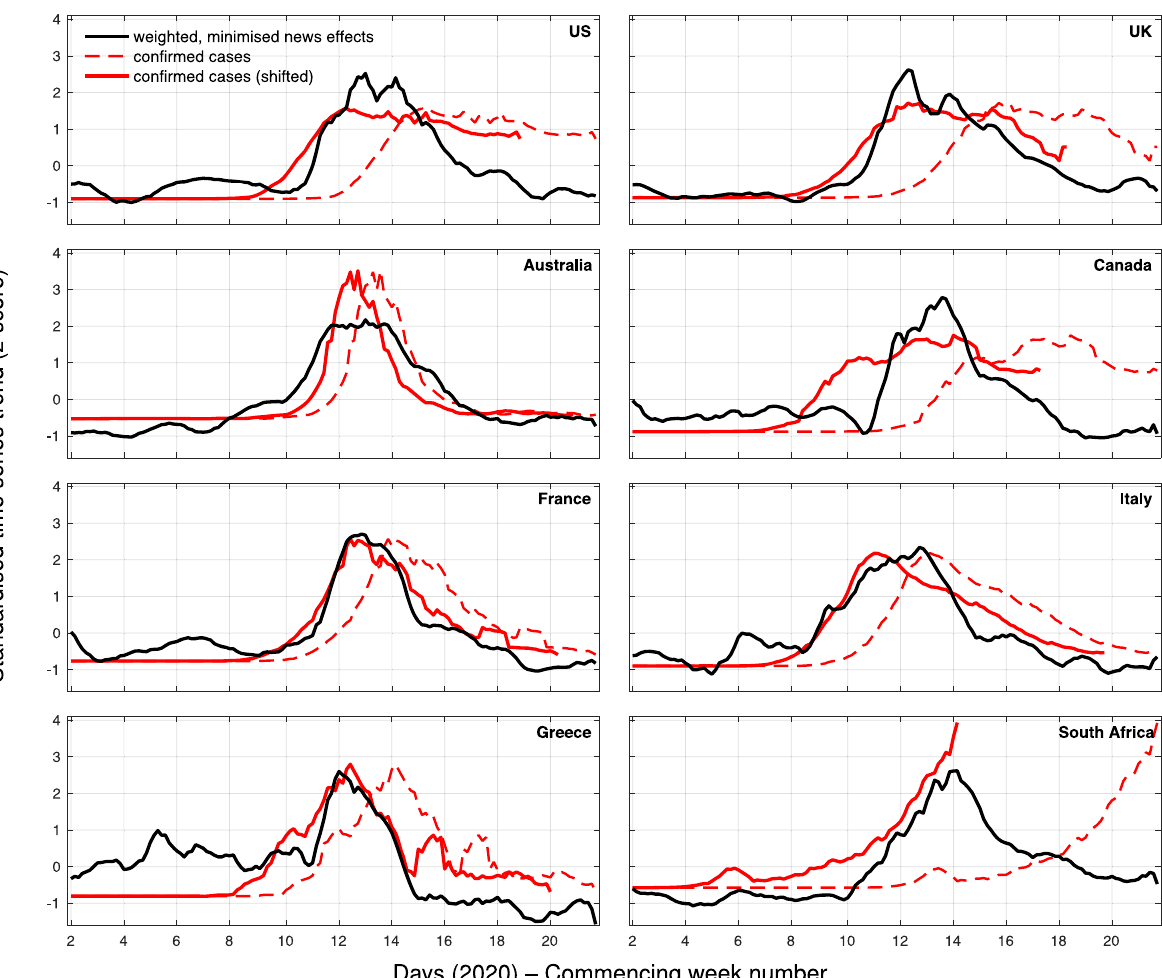
Fig. 2 Comparison between online search scores with minimised news media effects (black line) and con fi rmed cases (dashed red line), as well as con fi rmed cases shifted back (red line) such that their correlation with the online search scores is maximised. The con fi rmed cases time series are shifted back by a different number of days for each country: 20 days (US), 24 days (UK), 6 days (Australia), 31 days (Canada), 10 days (France), 14 days (Italy), 12 days (Greece), and 53 days (South Africa). All time series are smoothed using a 7-point moving average, centred around each